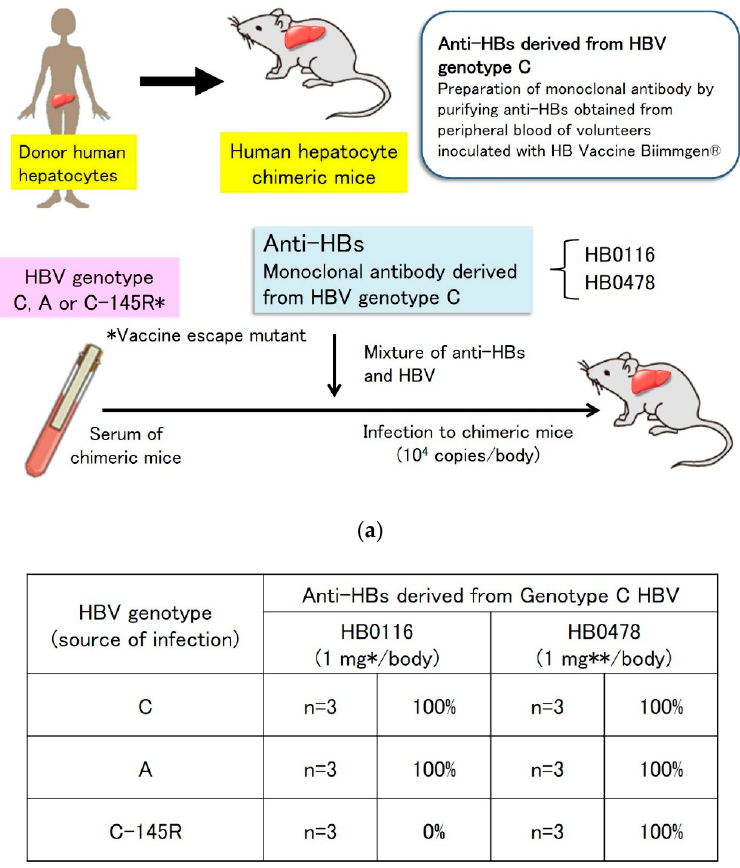
Figure 1. HBV infection protection test using chimeric mice. ( a ) HBV infection protection test using anti-HBs derived from genotype C HBV in chimeric mice. Chimeric mice were inoculated with these culture supernatants to obtain monoclonal and intact infectious virions. After establishing viremia in mouse. Five weeks after injection, serum HBV DNA was measured by quantitative PCR. ( b ) Protection rate against HBV infection in chimeric mice. Antibodies derived from genotype C HBV prevented